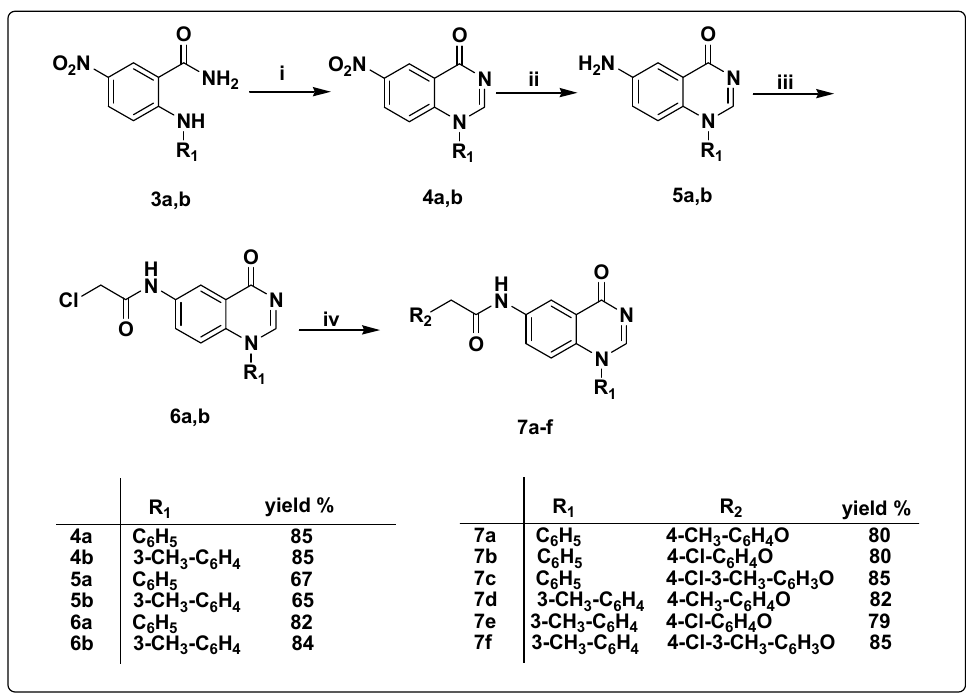
Scheme 2. Synthesis of the target quinazoline derivatives 7a – f (i) triethyl orthoformate, sulfuric acid, fusion, 100 ◦ C, 8 h; (ii) SnCl 2 , HCl, r.t, 2 h; (iii) chloroacetyl chloride, CH 2 Cl 2 , K 2 CO 3 , r.t, 3